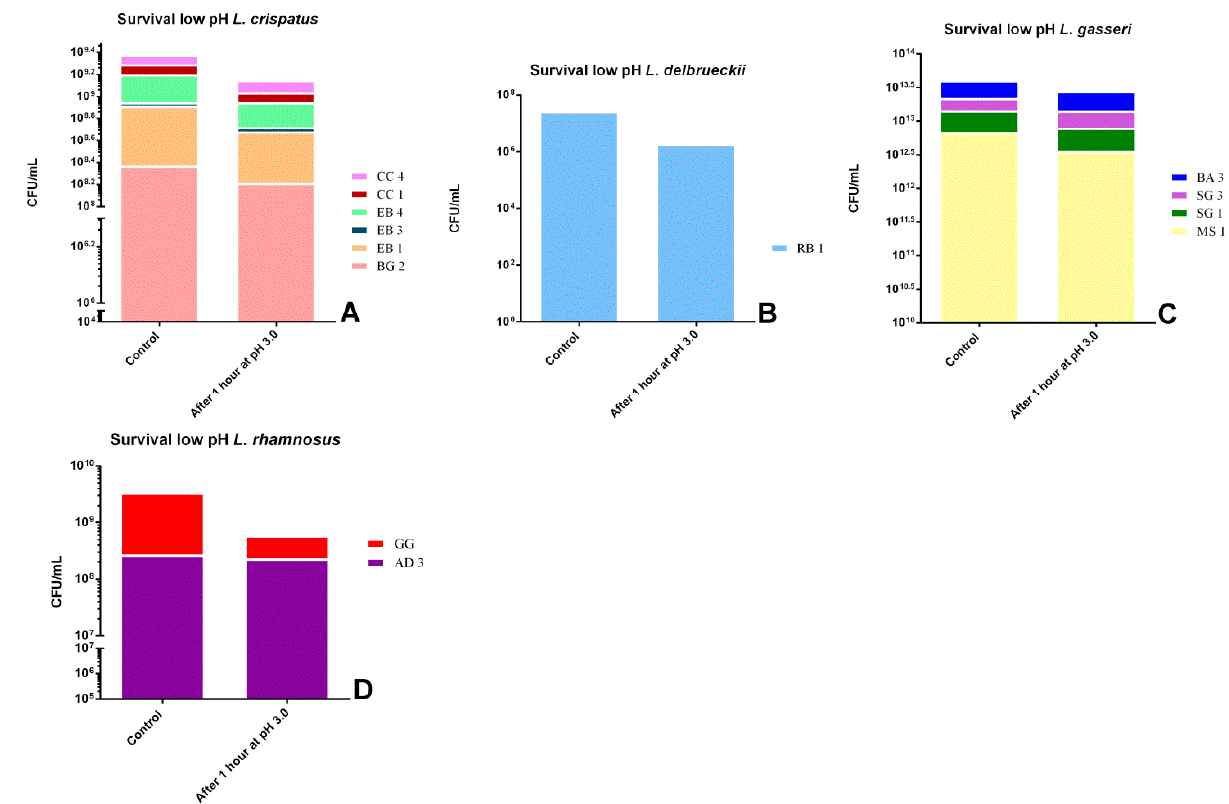
Figure 1. Comparison between control growth and growth after one hour of exposure to pH 3 by associating the strains by species: ( A ) L. crispatus strains,( B ) L. delbrueckii strain, ( C ) L. gasseri strains and ( D ) L. rhamnosus strains.